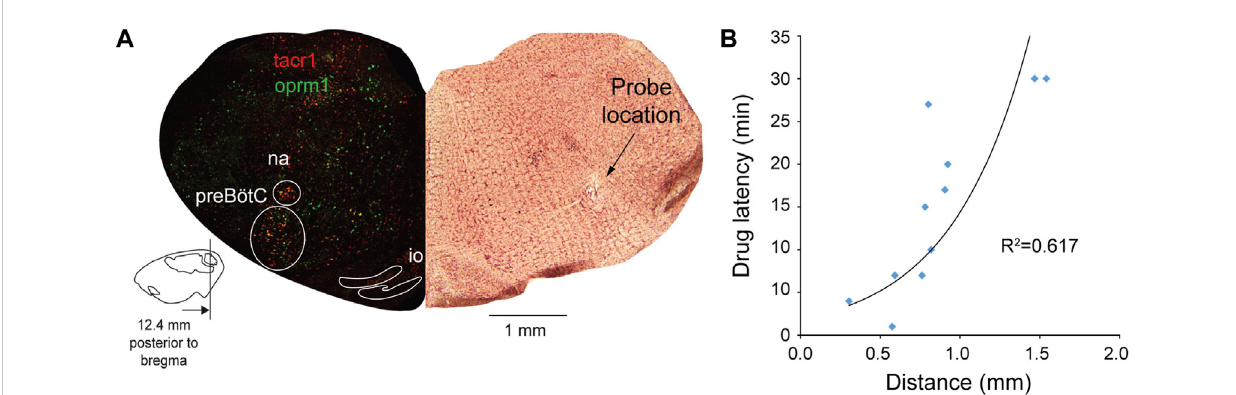
FIGURE 5 The site of action of DAMGO and CCG50014 overlaps with Oprm1 and Tacr1 expressing neurons. Using the same approach than in the gallein experiments, we determined the sites of drug perfusion and the latency for respiratory rate to decrease in response to DAMGO. Drugs were microperfused in the preBötC region as identi fi ed with expression of Tacr1 (gene for neurokinin-1 receptors) (A) . A signi fi cant correlation was observed between distances from probe site to the centre of the preBötC and the latency for DAMGO to depress respiratory rate by 10% (B) . Na, nucleus